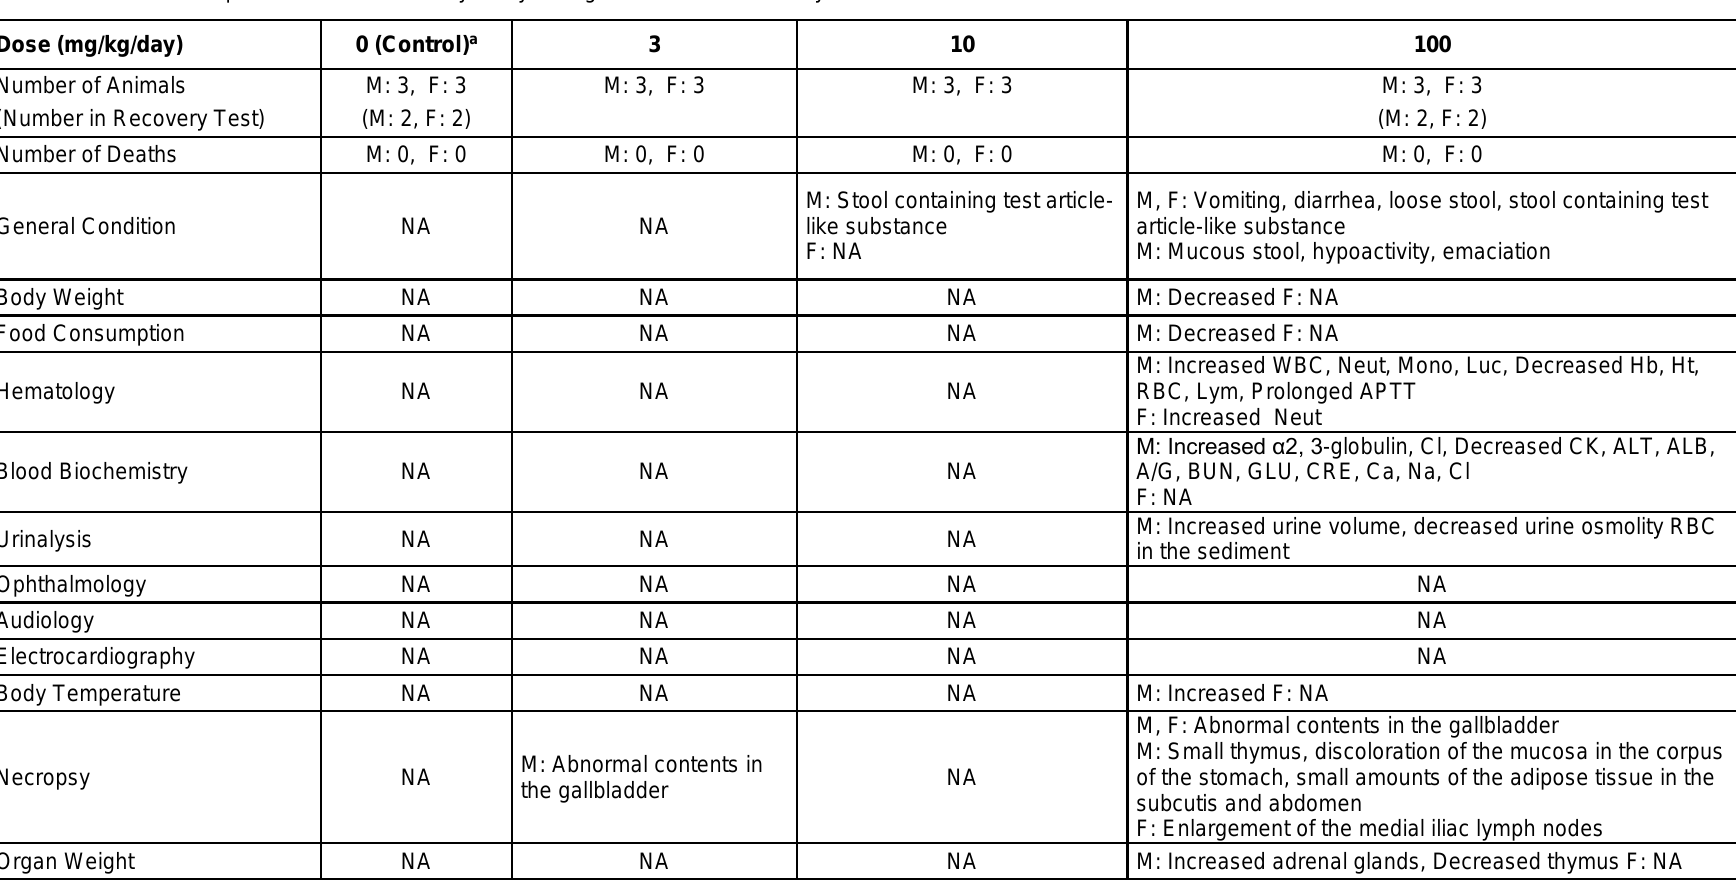
Table 3: Four-week repeated-dose oral toxicity study in dogs with 4-week recovery test Dose